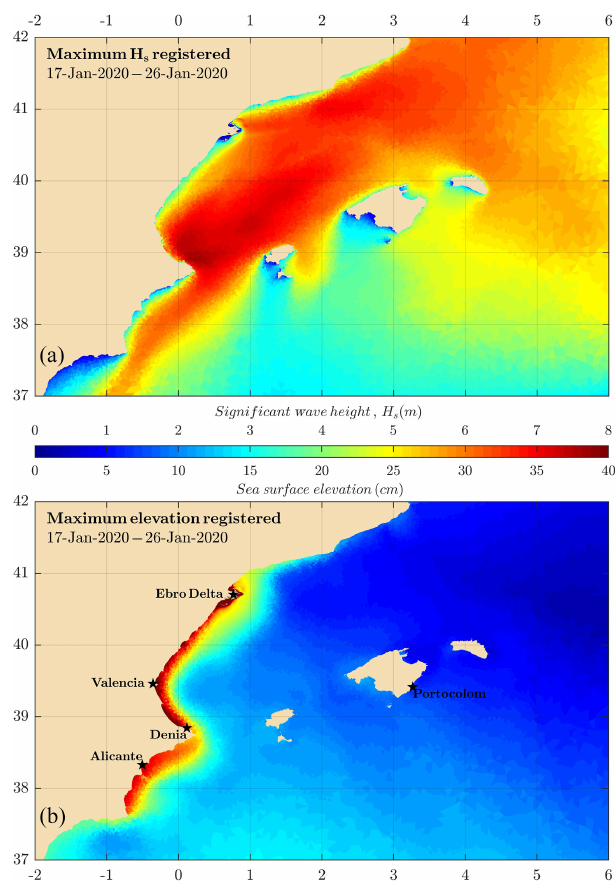
Figure 5. Maximum values of H s (a) and sea surface eleva- tion (b) during the simulation